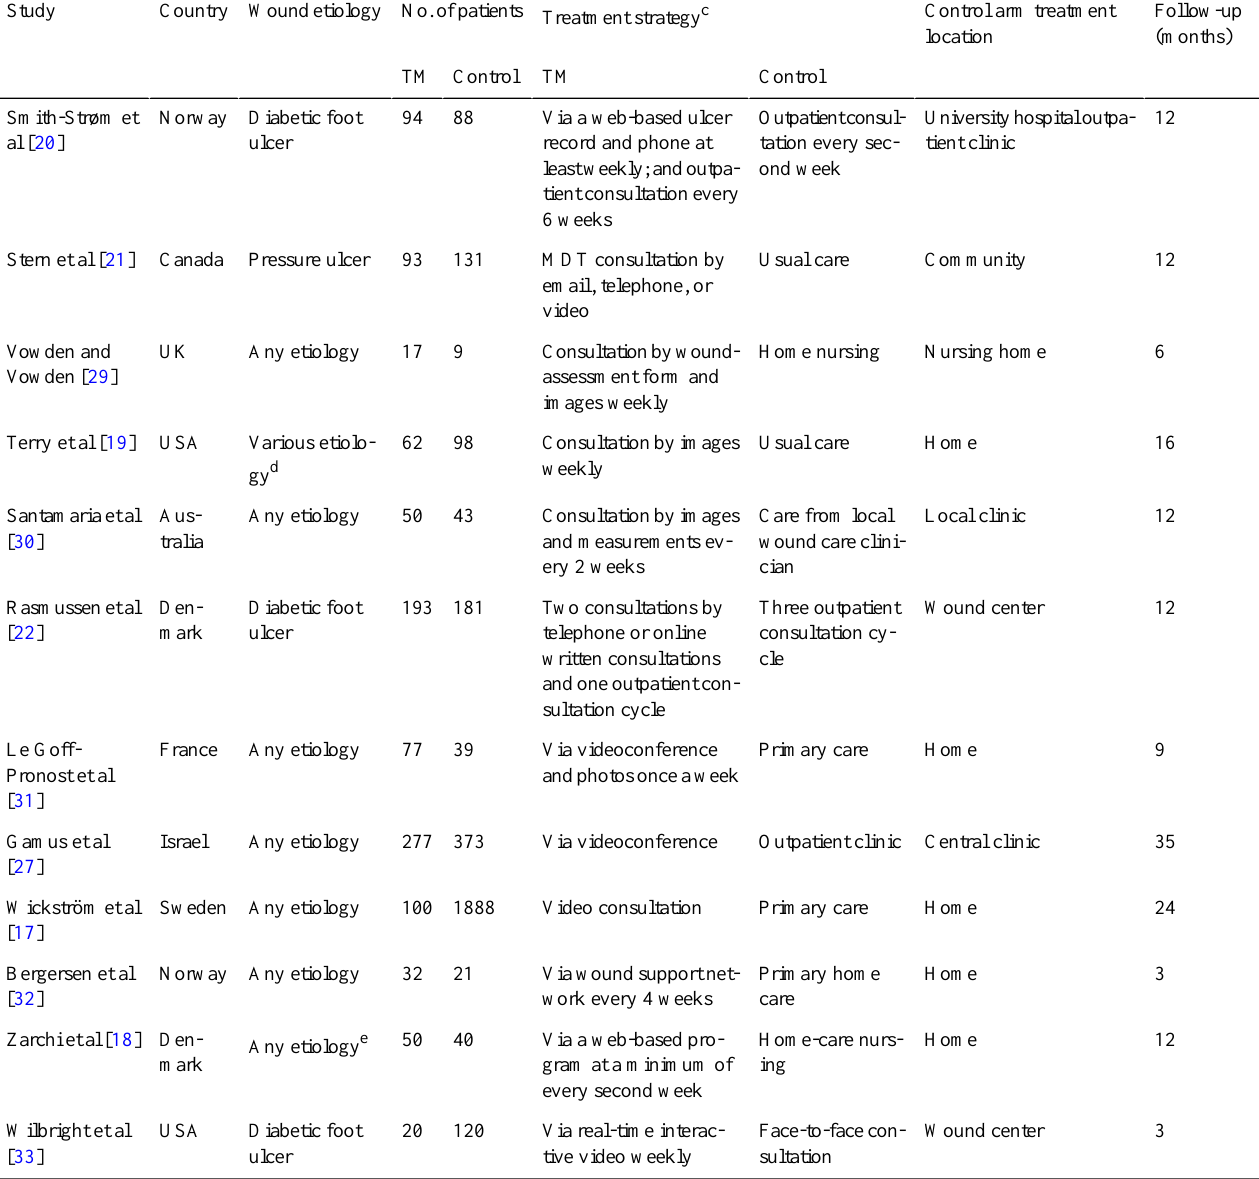
Table 1. Characteristics of the clinical trials